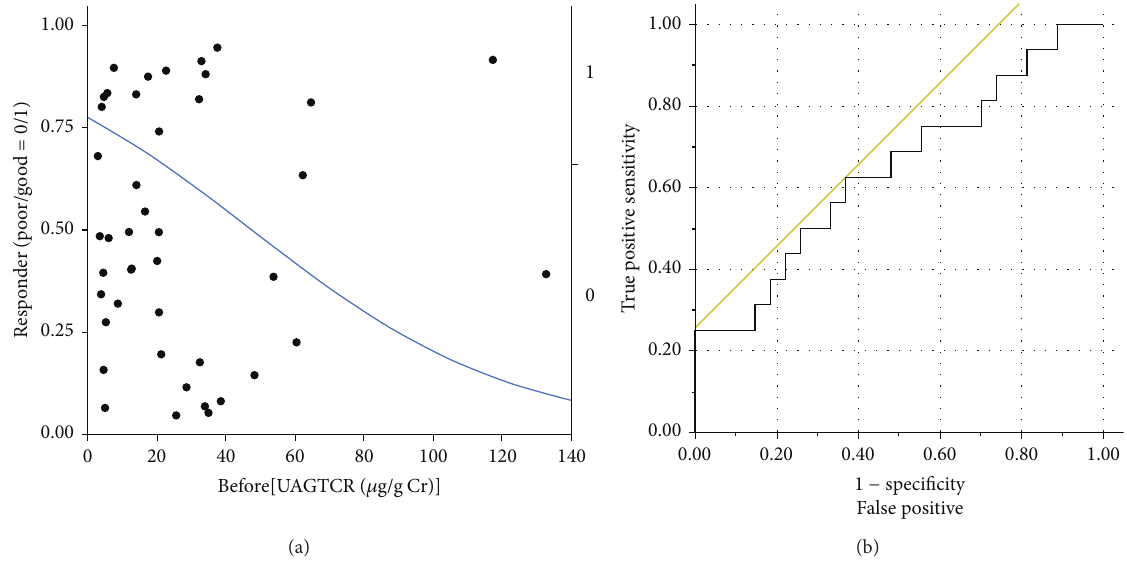
Figure 2: Logistic analysis of urinary concentrations of angiotensinogen normalized by urinary concentrations of creatinine (UAGTCR) before treatment. Good responders to the alogliptin treatment were defined in terms of % change in urinary concentrations of Alb normalized by urinary concentrations of creatinine less than − 25% after the 12-week treatment, and a logistic analysis of UAGTCR before treatment showed the area under the curve as 0.644. When we set the cutoff value of UAGTCR as 20.8 𝜇 g/g Cr, the maximum specificity (17/27 = 63.0%) and sensitivity (10/16 = 62.5%) were obtained (Youden index =